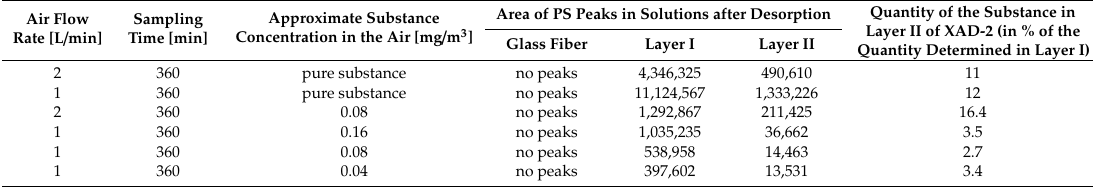
Table 1. Results of PS adsorption on XAD-2 resin (ORBO ™ -43)—toluene desorption. GC-MS, HP-5MS column, programmable column temperature.